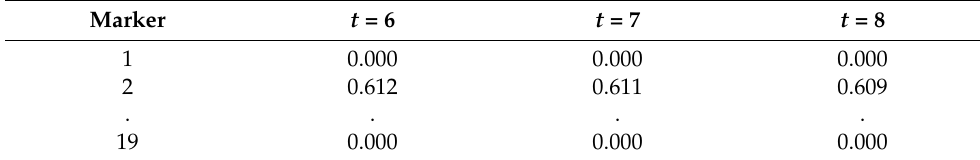
Figure 10. Original and reconstructed series of z coordinates of M 2 . Aggregated mean absolute percentage error (AMAPE) of reconstruction stage of z coordinates is 0.18%. Forecasted z coordinates of the markers for h = 1 step ahead are obtained according to Equation (12) and represented in Table 15. Table 15. Forecasted z coordinates for h = 1.